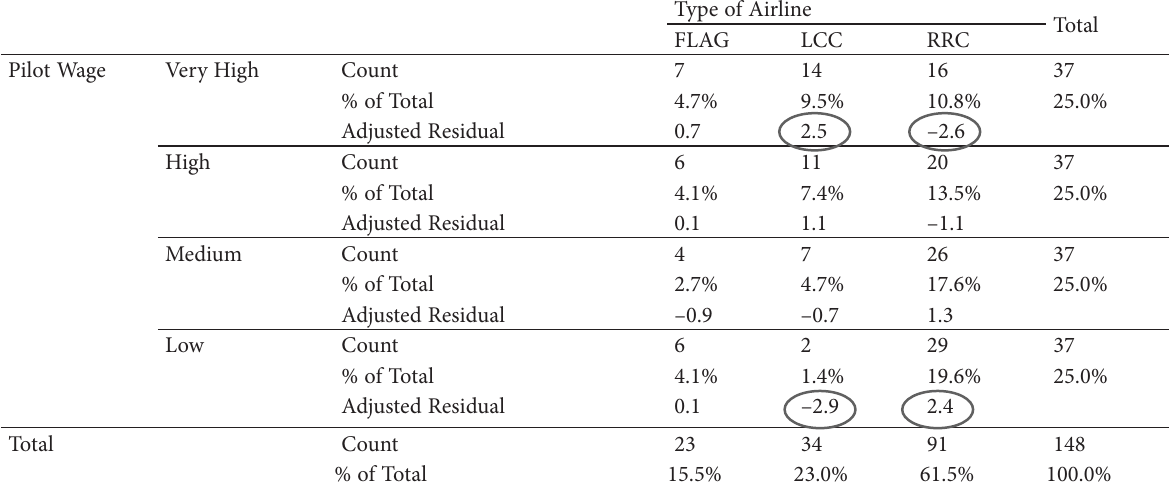
Table 5. Captain Base 2008. Crosstabs adjusted and standardised by